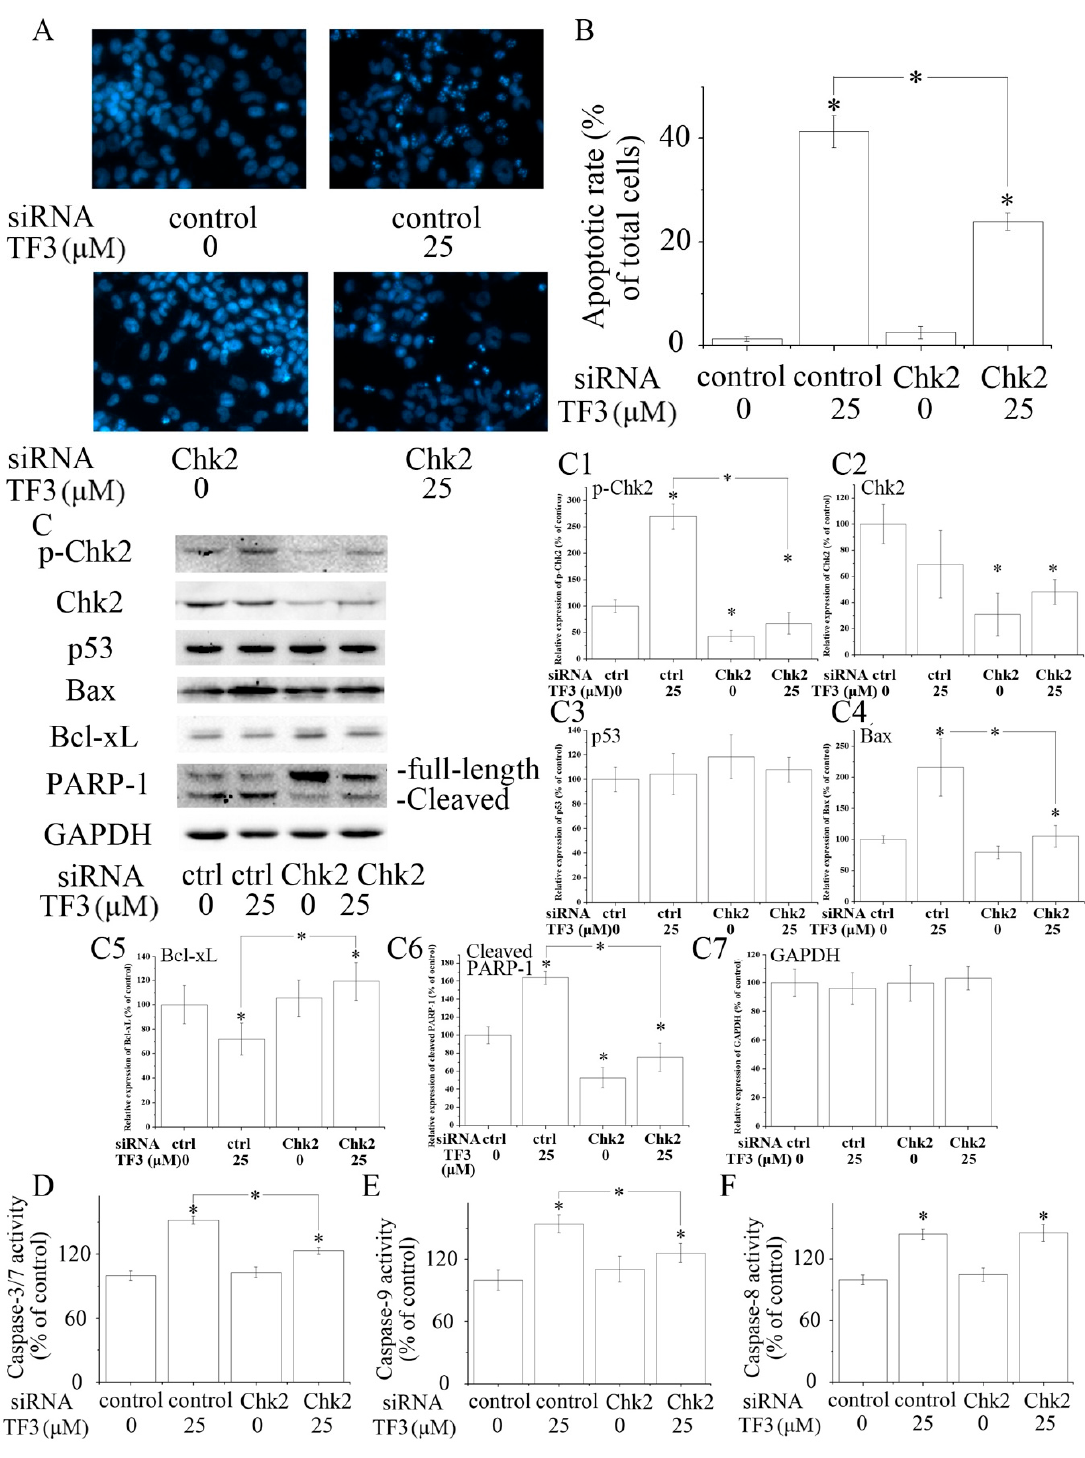
Figure 3. The role of checkpoint kinase 2 (Chk2) in theaflavin-3, 3'-digallate (TF3)-induced apoptosis. ( A , B ) Blocking Chk2 impaired TF3-induced apoptosis. ( C ) Blocking Chk2 partially reversed TF3-induced increase of the expression of p-Chk2, Bax and cleaved poly (ADP-ribose) polymerase 1 (PARP-1), as well as a decrease of the expression of Bcl-xL. ( C1 – C7 ) Densitometry analysis of protein bands. ( D – F ) Blocking Chk2 attenuated the activation of Caspase-3/7 and 9 induced by TF3. However, the activity of Caspase-8 was not affected. * p < 0.05 compared with control or between specific groups. 2.4. TF3 Induces G0/G1 Cell Cycle Arrest in OVCAR-3 Cells via p27